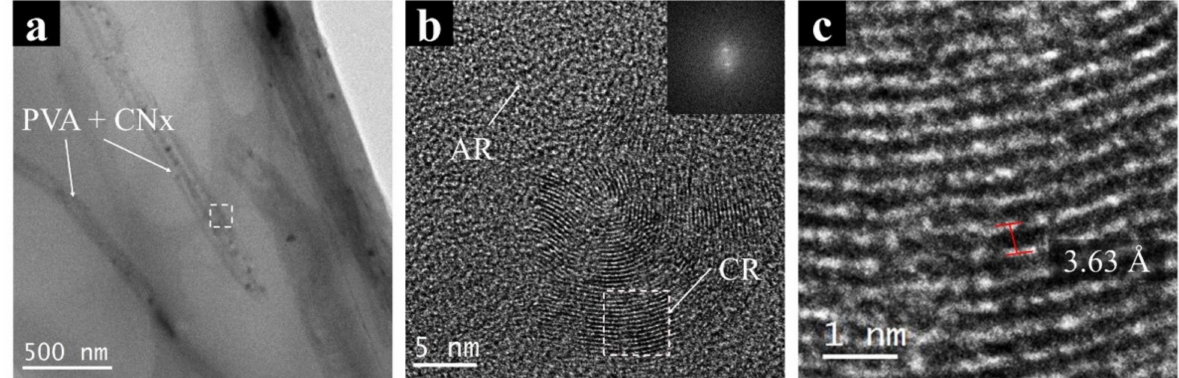
Figure 7. Transmission electron micrographs of ( a ) PVA + CNx nanofibers and ( b ) the magnification image of the nanocom- posite showing their crystallographic structure. ( c ) Reconstruction of the FFT to IFFT showing the interplanar distances in CNx. AR: amorphous regions; CR: crystalline